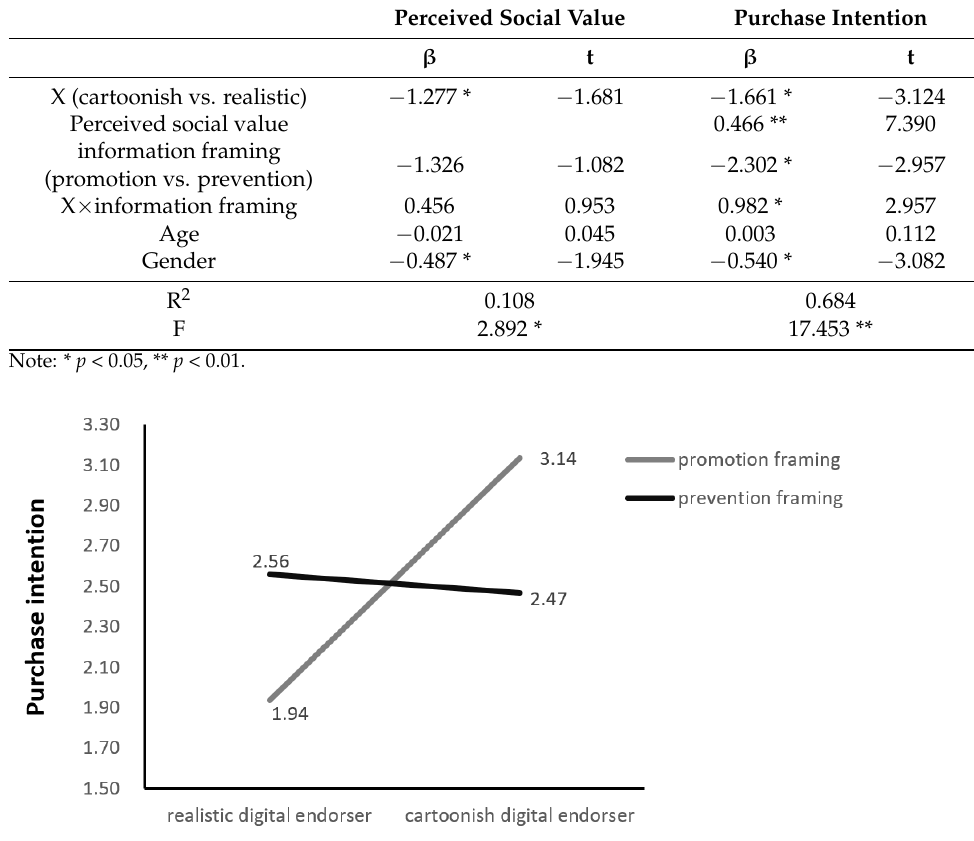
Figure 6. Moderating effect of information framing.